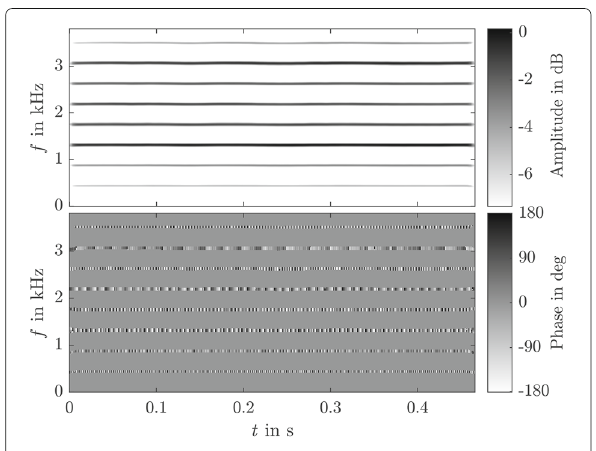
Fig. 1 Excerpt of the spectrogram for the signal of a trumpet playing note A4 (440 Hz) at fortissimo, recorded with microphone 4 from [12], separated in amplitude in dB (top) and phase in degree